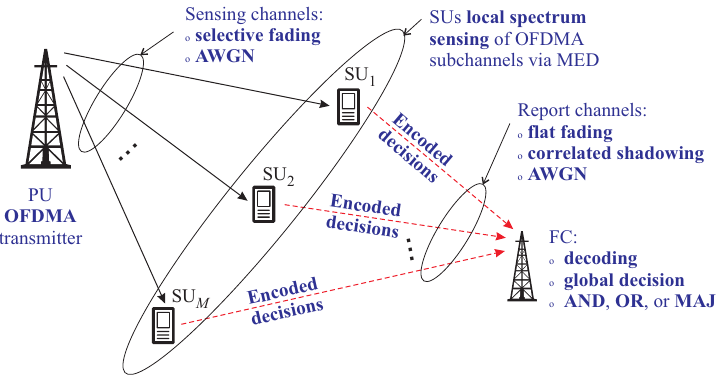
Figure 1. Centralized decision fusion CSS of OFDMA